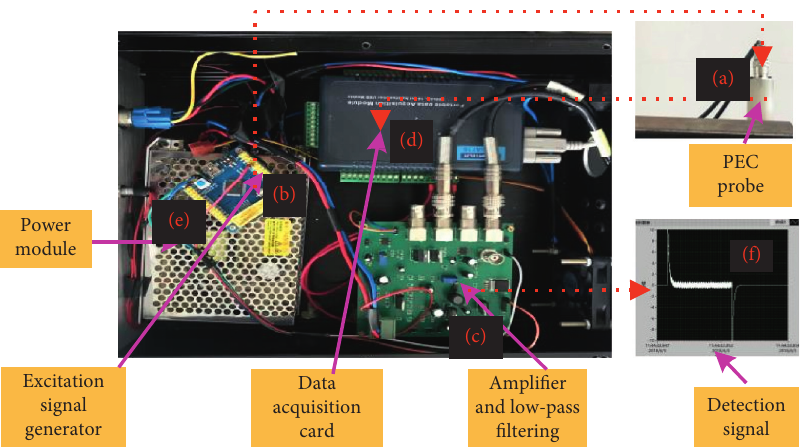
Figure 1: Overview of self-made experimental equipment: (a) PEC probe; (b) excitation signal generator; (c) amplifier and low-pass filtering; (d) DAC; (e) power module; (f) detection signal.